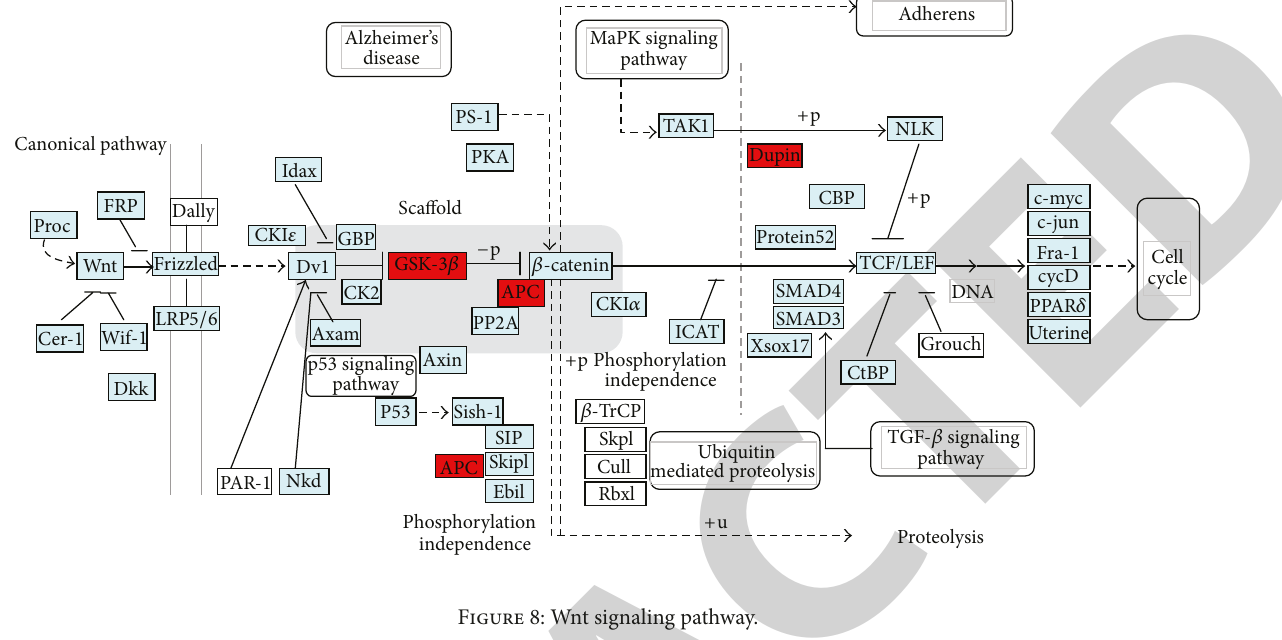
Figure 8: Wnt signaling